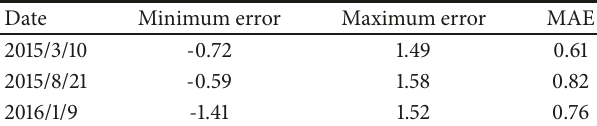
Table 6: Prediction error of the GBDT